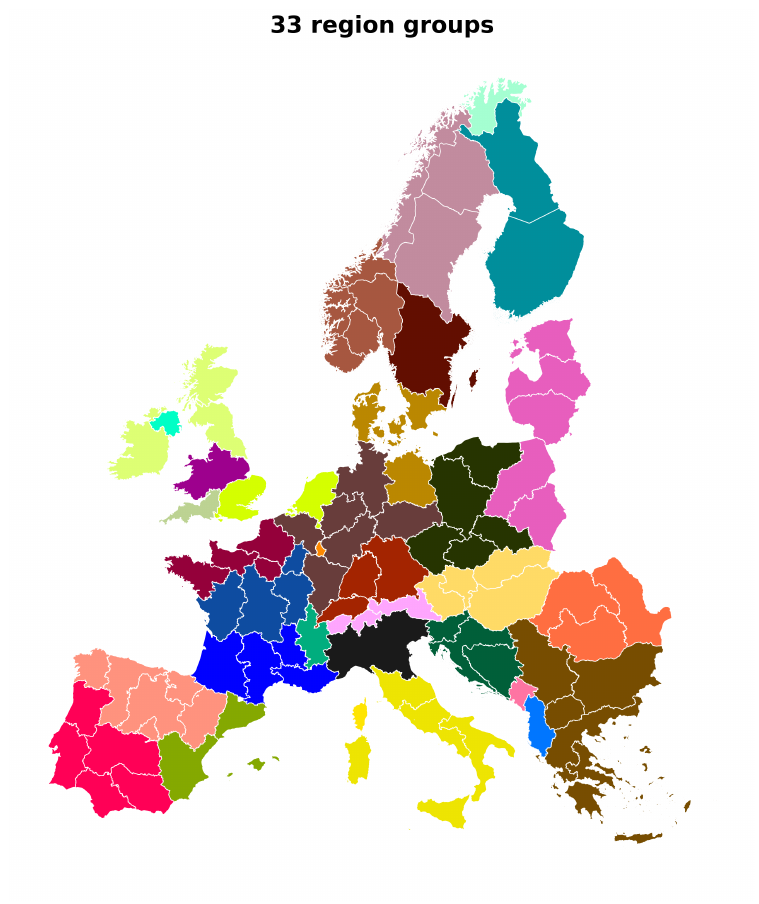
Figure 13. The 33 regions groups obtained when spatial aggregation is performed. According to the elbow criterion employed, 33 aggregated regions are